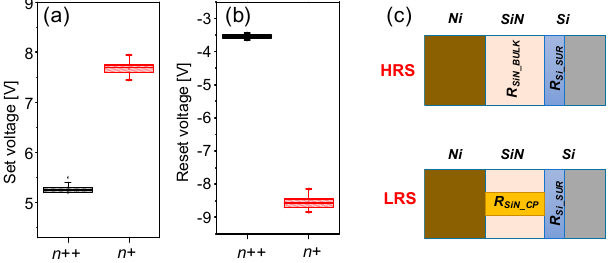
Figure 4. Statistical distribution of ( a ) the set voltage and ( b ) the reset voltage; ( c ) Schematics illustrating the Ni/SiN/Si structure in the high resistance state (HRS) and the low resistance state (LRS). Materials 2017 , 10 , 459